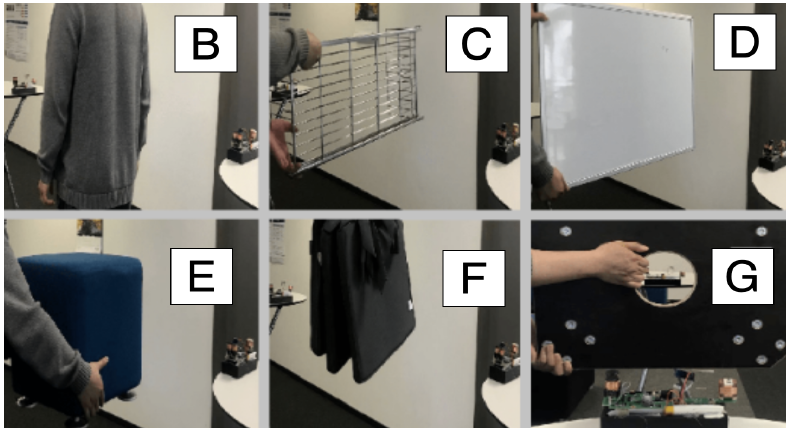
Figure 12. Robustness test with various obstacles between two prototypes: in case ( B ), a human body as the obstacle; case ( C ) to ( G ) with obstacles of a metal frame, plastic, sofa with wood and metal, thick textile, and thick wood, respectively. The corresponding rectified strength signal is depicted in Figure 14.